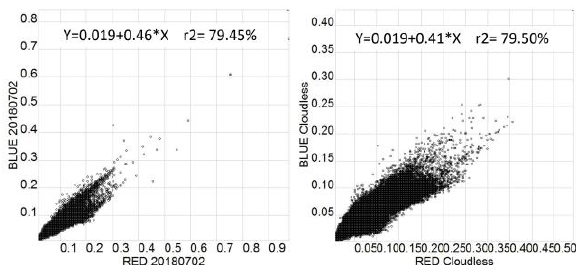
Figure 13. Correlation analysis between Blue band (y axis) and Red band (x axis), for the 20 km sampling area. (Left) Original image taken at July 02, 2018; (Right) Cloudless image obtained by means of the M2CTool